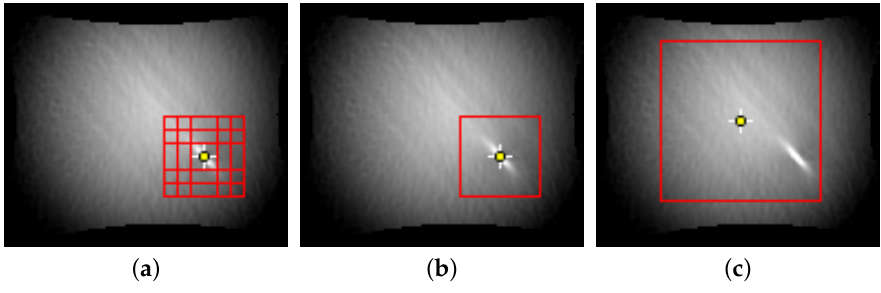
24) are distributed ×